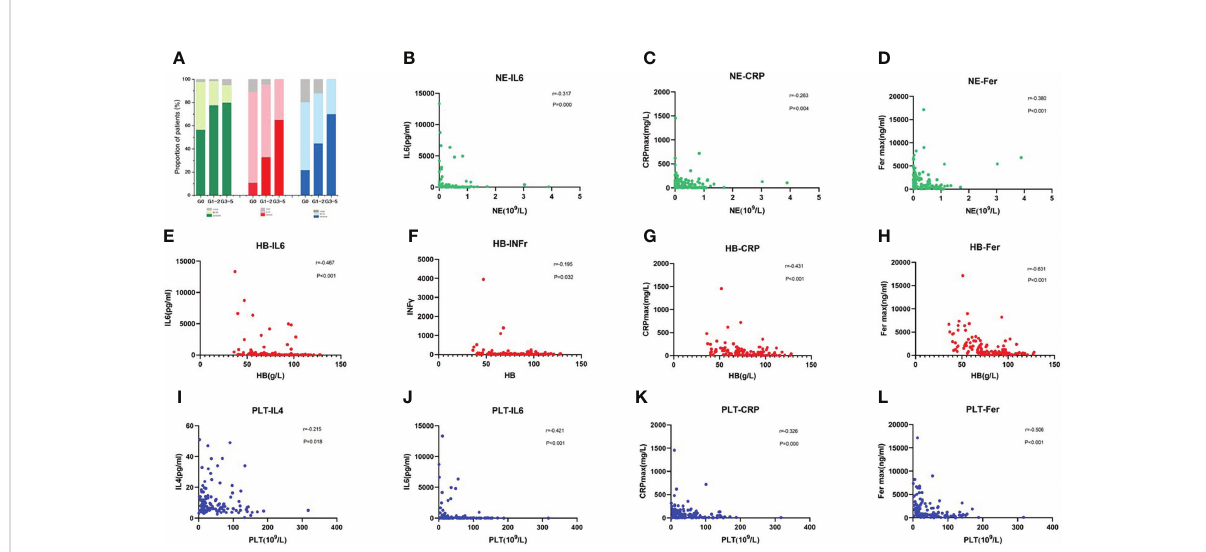
FIGURE 3 CRS and In fl ammatory Cytokine Levels Correlate with the Occurrence of Early Severe Haematologic Toxicity (A) Incidence of each cytopenia is shown in patients without CRS or mild or severe CRS. (B – L) Correlation of in fl ammatory factors and blood cell parameters, including neutrophil count (B – D) , hemoglobin concentration (E – H) , and platelet count (I – L) . P values and r values were determined by Spearman correlation